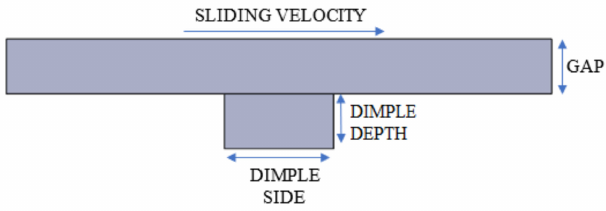
Figure 1. Graphic representation of the single dimple configuration with the main geometric features.